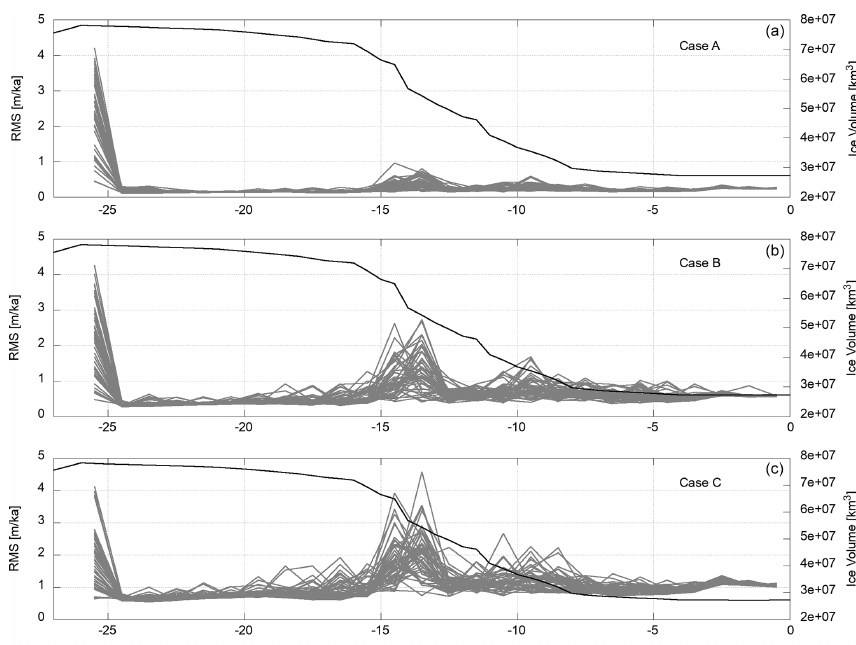
Figure 5. Measures of misfit variation for the ensemble of set-up 1 (Cases A–C) in grey. Shown are the RMS values of the difference between the sea level rate of change observations and the model predictions of each ensemble member. The black lines show the total ice volume according to the external ice model. There are spikes following large changes in total ice mass. They appear due to the large amount of fresh water that changes the RSL independently of the viscosity